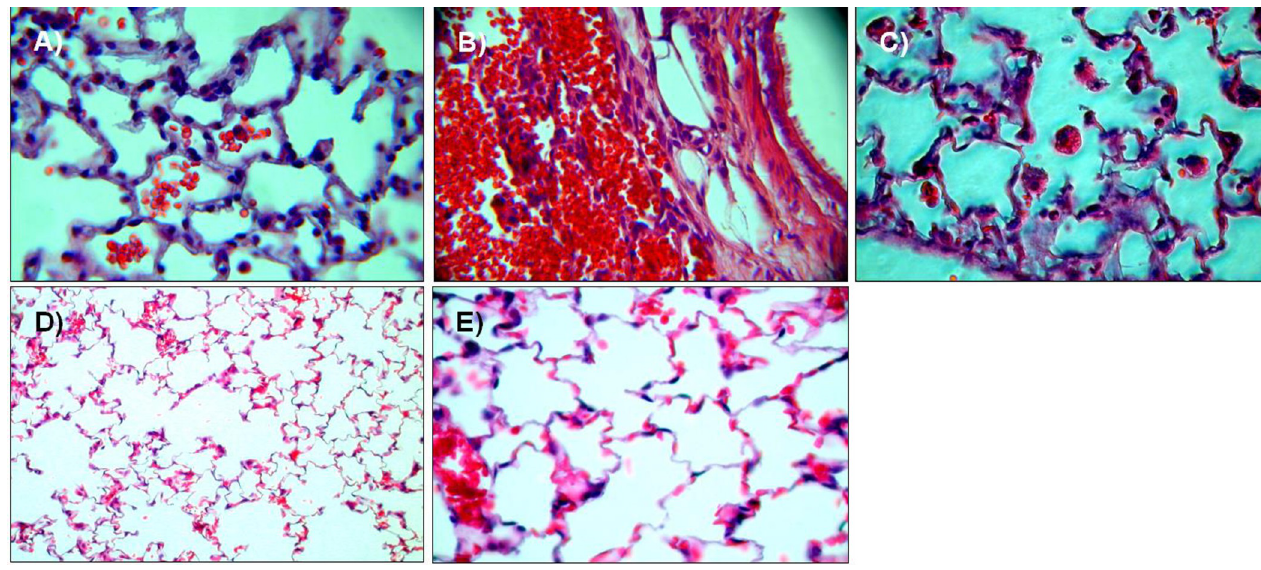
Fig 2. Histopathology of rat blast injury. Rats were exposed to the pressure wave at 3.5 cm from the nozzle. Animals were sacrificed either 10 min A) , 3 hours B) or 24 hours C) after blast exposure, non-traumatized animals served as sham controls E) + D) . Visualized at an original magnification of 40-fold A) – C) + E) and 10-fold in D)